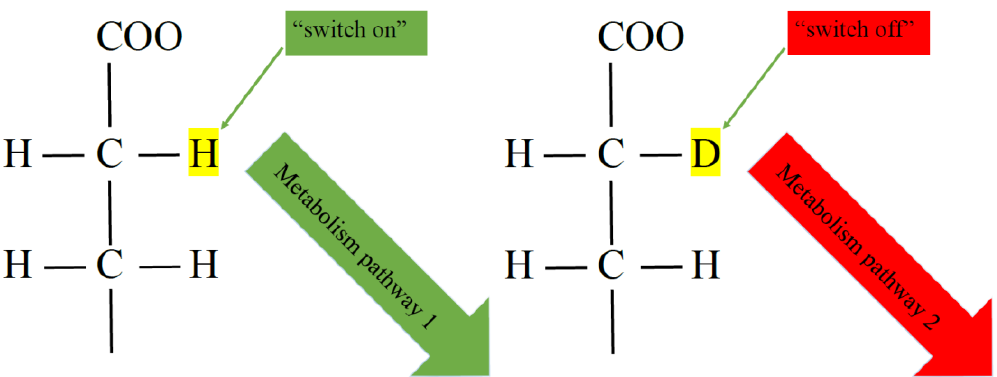
Figure 1. Scheme of changes in deuterium metabolism depending on chirality according to the “switch on/off” mechanism.